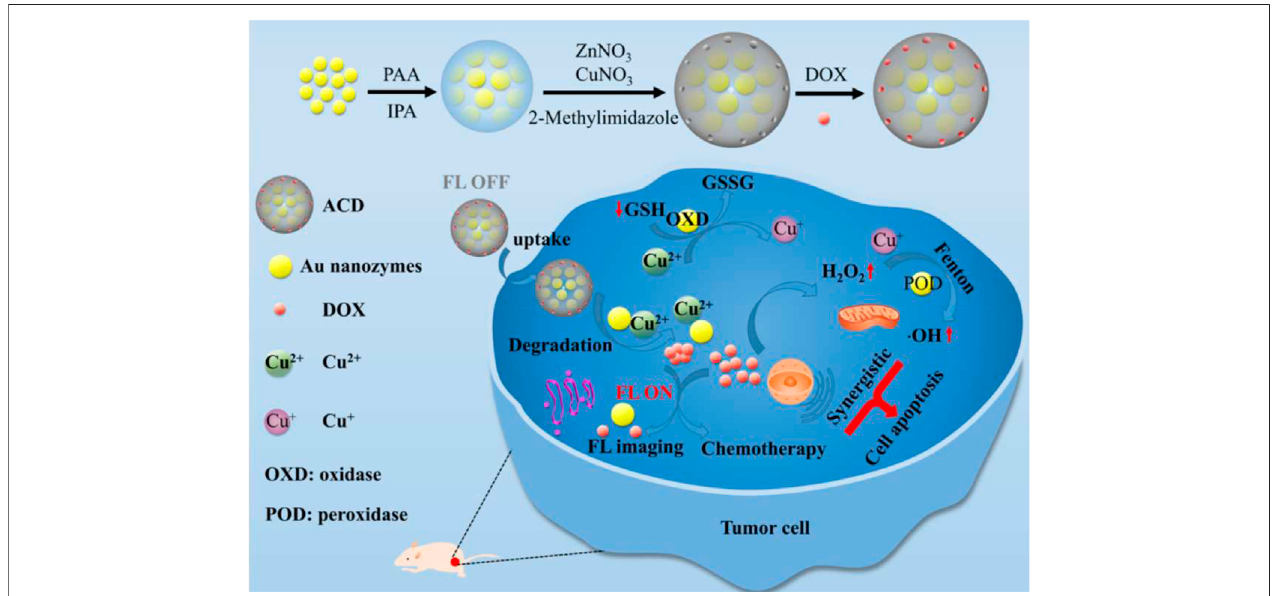
FIGURE6| AschematicdiagramoffabricationprocedureofACD(ACD,A:Aunanoclusters,C:copperions,D:DOX)anditsuseforboth fl uorescenceimagingand enhancing chemo-chemodynamic therapy. Reprinted (adapted) with permission from Zhao et al. (2021). ACS Appl Mater Interfaces. 2021,1,13 (47):55,780-55,789. Copyright 2021 American Chemical